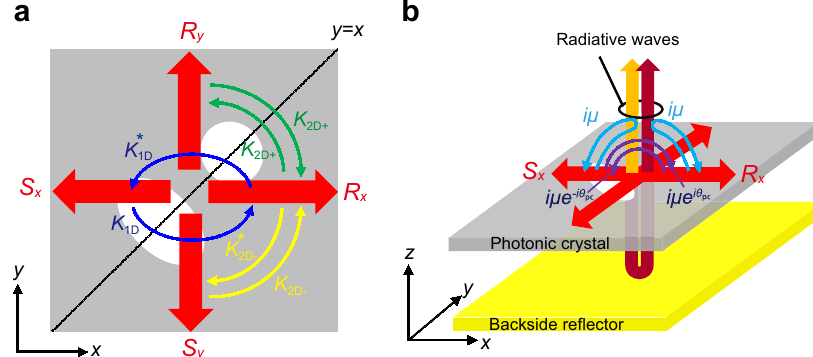
Fig. 1 Hermitian and non-Hermitian optical couplings inside PCSELs. a Hermitian couplings between the four fundamental waves ( R x , S x , R y , S y ) inside a PCSEL. b Non-Hermitian couplings via radiated waves, where a backside re fl ector is used for the control of the non-Hermitian coupling coef fi cient i μ